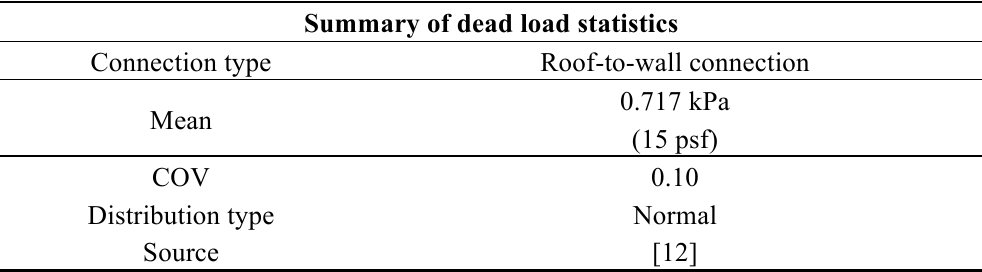
Table 4. Summary of dead load